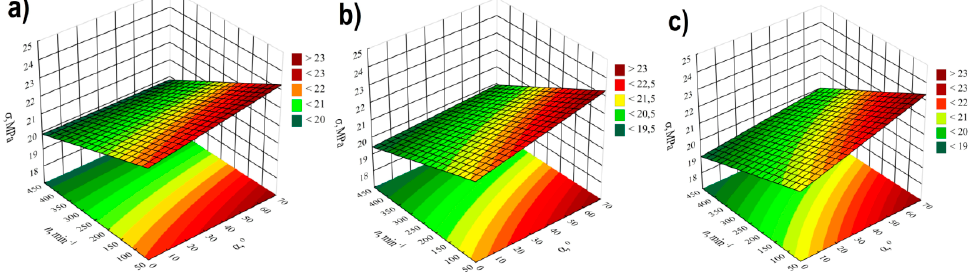
Figure 8. Response surface plots for tensile strength σ based on screw rotational speed n and angle between the kneading elements α , with a talc content of ( a ) u = 10%; ( b ) u = 13%; ( c ) u =